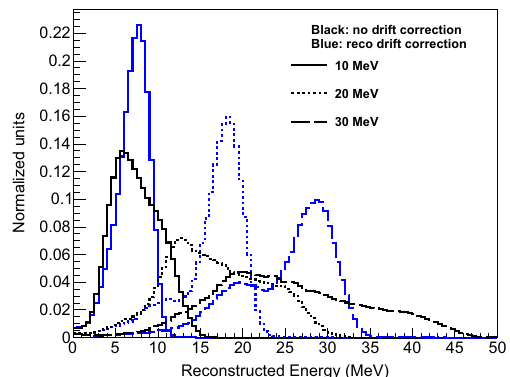
Fig. 9 Observed reconstructed energy distributions for specific inter- acting neutrino energies (corresponding to columns of the transfer